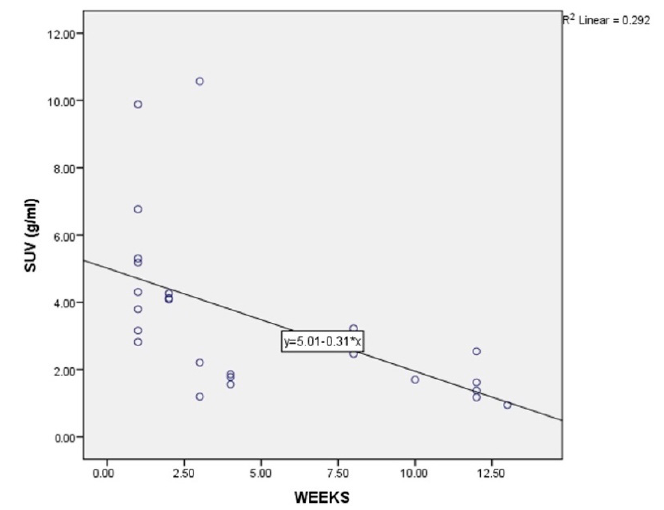
Figure 1. Correlation of SUVg/mL and time between vaccination and PET-CT examination; RHO = − 0.54, p = 0.005.